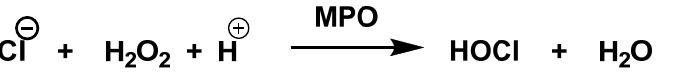
Figure 6. Production of hypochlorous acid from hydrogen peroxide and chloride.